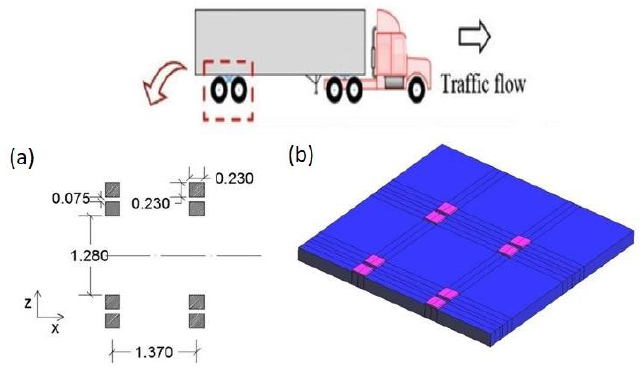
Figure 1. ( a ) Dual tyre tandem axle ( b ) critical load axle location